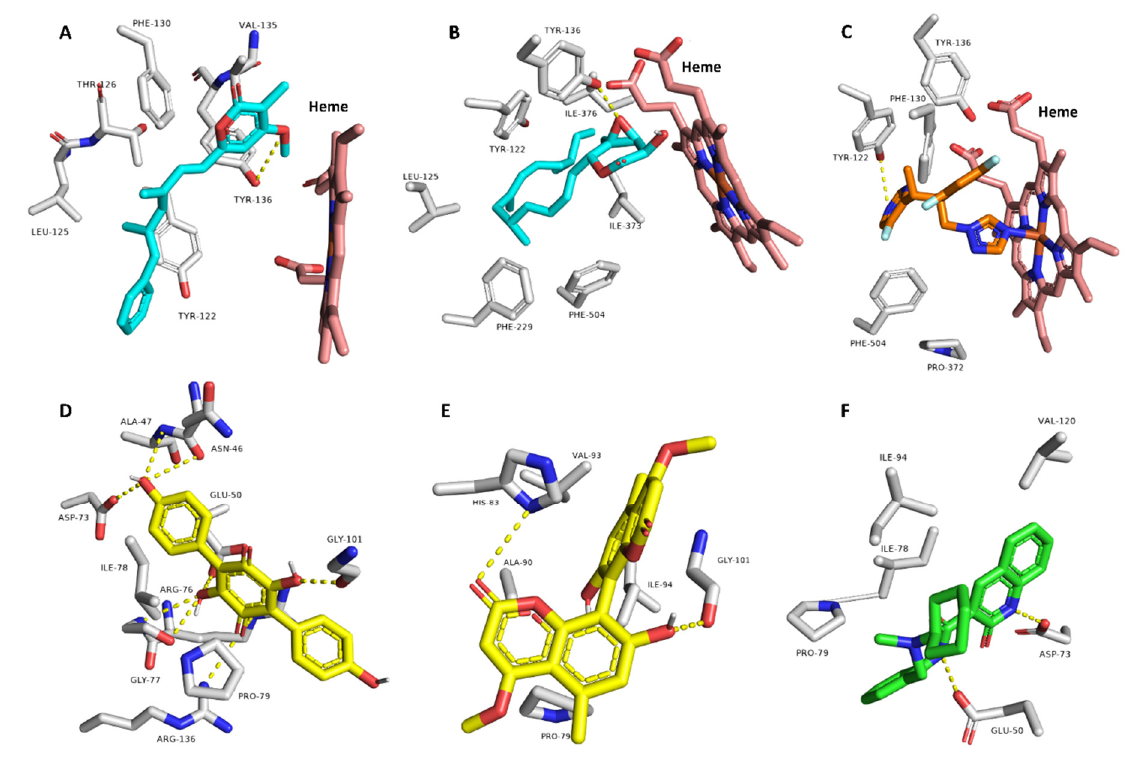
Figure 7. Predicted binding modes of compounds 3 and 15 (( A , B ), respectively) inside the active site of C. albicans ’s CYP 51 and compounds 13 and 17 inside the active site of E. coli’s Gyr-B (( D , E ), respectively), alongside the co-crystallized inhibitors (( C , F ), respectively).